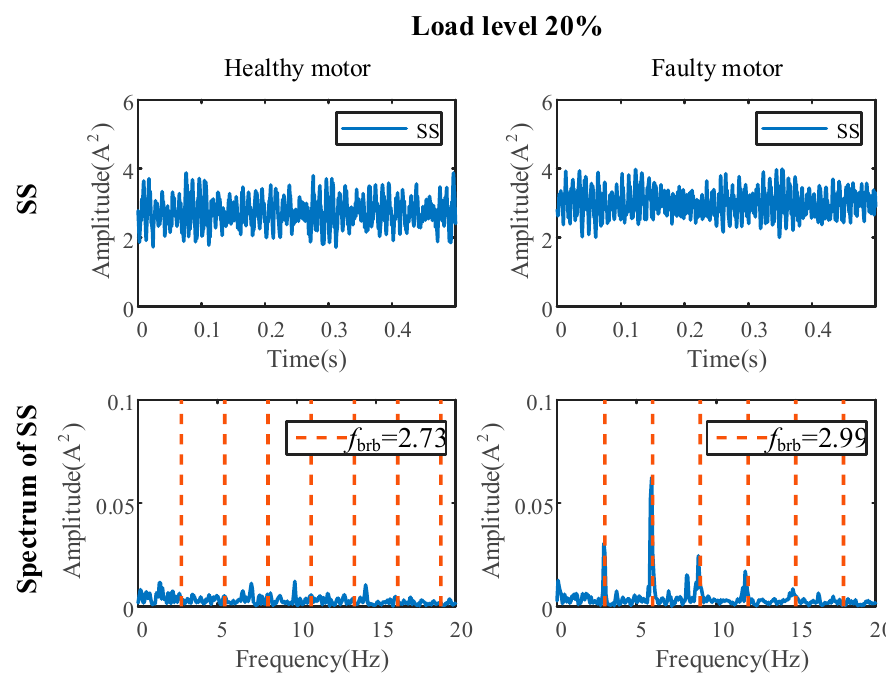
Figure 5. The SS signal and its spectrum of healthy motor and faulty motor at 60% load.